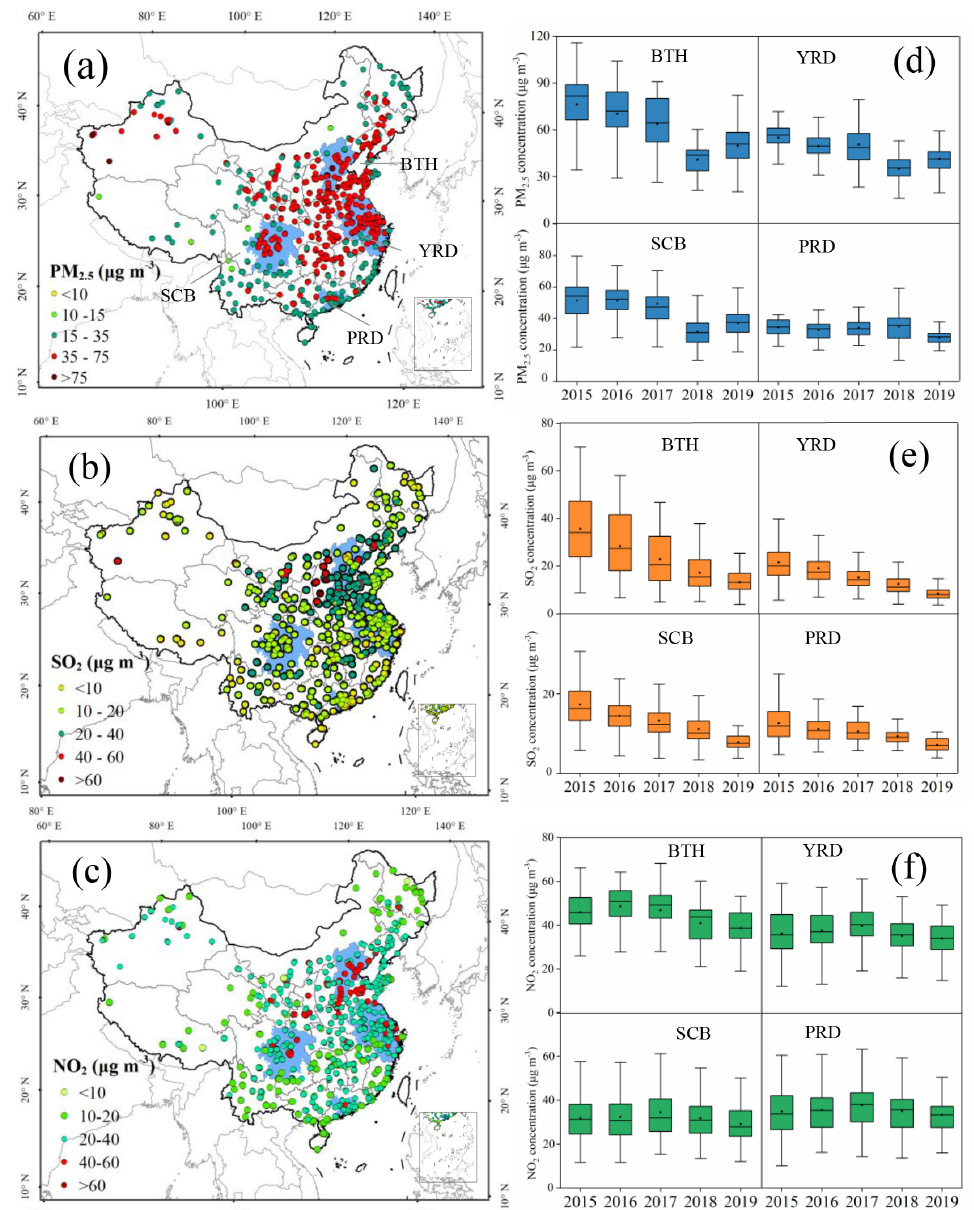
Figure 3. Left: spatial patterns of annual mean observed concentration of (a) PM 2 . 5 , (b) SO 2 , (c) NO 2 at 1498 sites, averaged for the period 2015–2019. Right: the annual observed concentrations of (d) PM 2 . 5 , (e) SO 2 , and (f) NO 2 for the period 2015–2019 in four megacity clusters (BTH: Beijing–Tianjin–Hebei, YRD: Yangtze River Delta, SCB: Sichuan Basin, PRD: Pearl River Delta). The locations of the regions are indicated by the blue shading on the map. The upper and lower boundaries of the boxes represent the 75th and 25th percentiles; the line within the box represents the median value; the whiskers above and below the boxes represent the 90th and 10th percentiles; the point within the box represents the mean